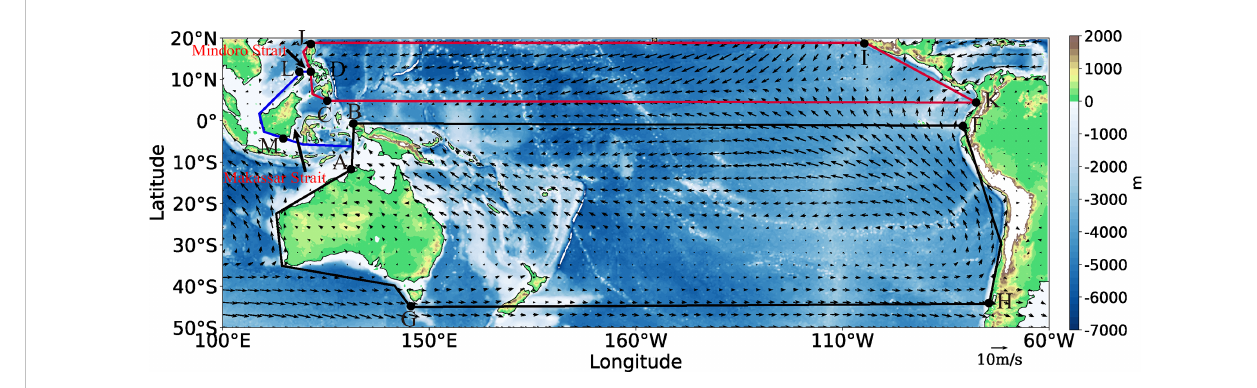
FIGURE 7 Integral paths (red, blue and black lines) and climatological sea surface winds (vectors). Color shading shows the topography (unit in